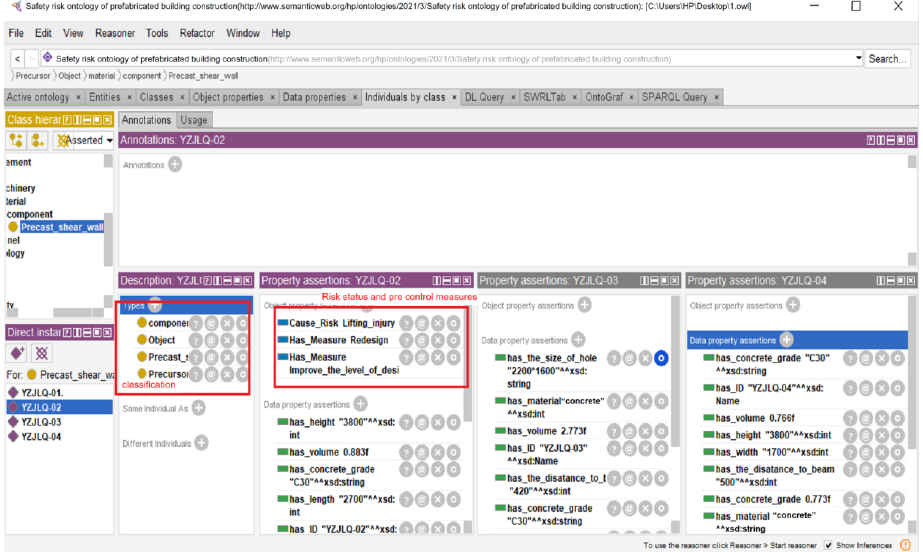
Figure 14. Ontology reasoning results.